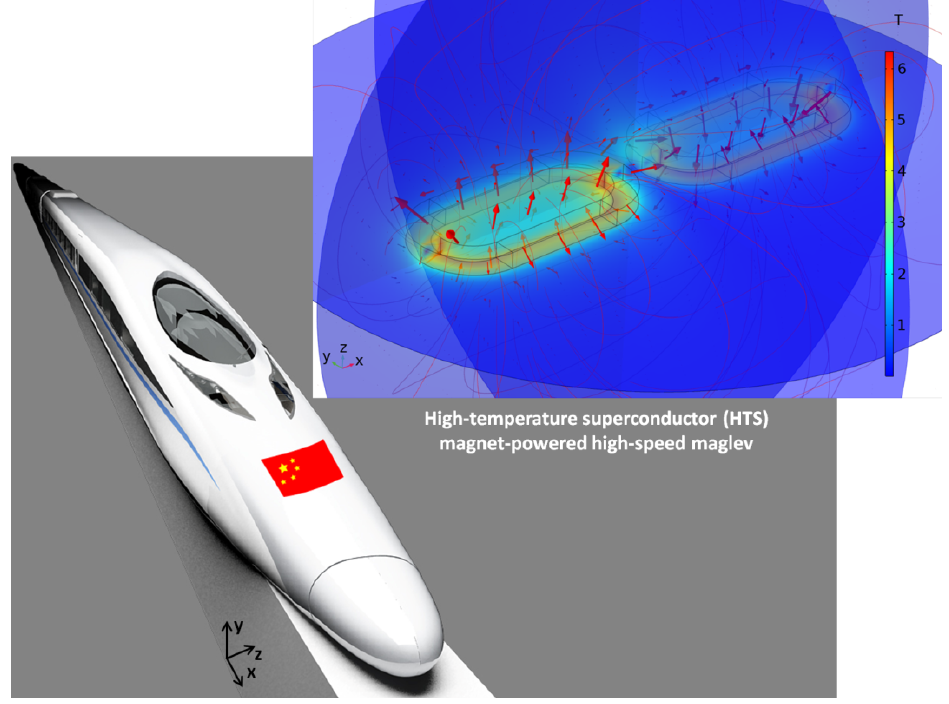
Figure 1. High-speed maglev for a proposed top speed over 600 km/h (conceptual design), the HTS magnet, and the magnetic fields.